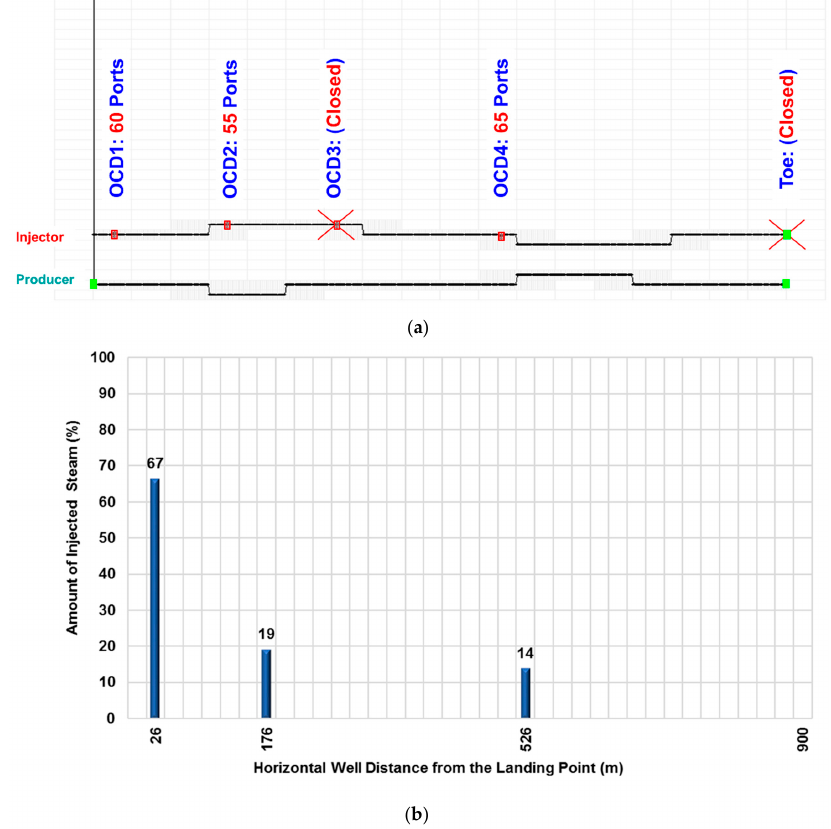
Figure 9. Distribution of injected steam among OCDs at the end of the SAGD’s project life. ( a ) SAGD well pair; ( b ) cold water equivalent (CWE) of cumulative steam injected through injector OCDs at the end of SAGD (CWE m 3 ).